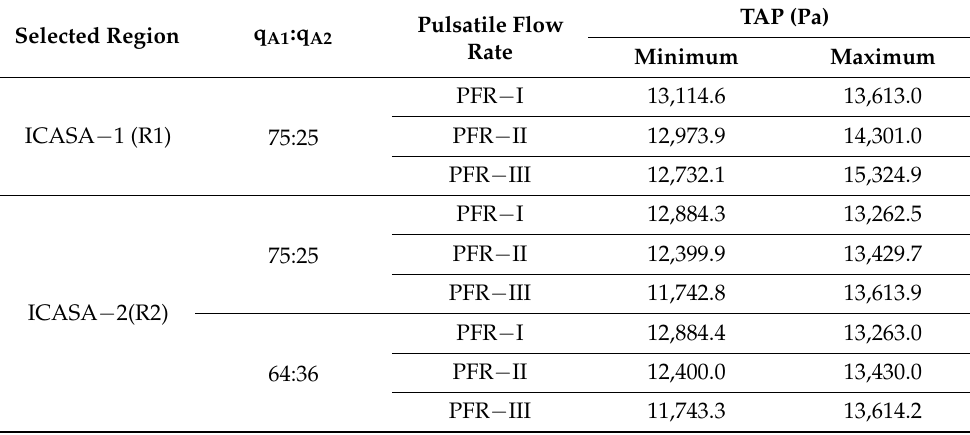
Table 4. TAP (Pa) in aneurysmal regions (R1 and R2) under different PFRs and shunt ratios. Selected